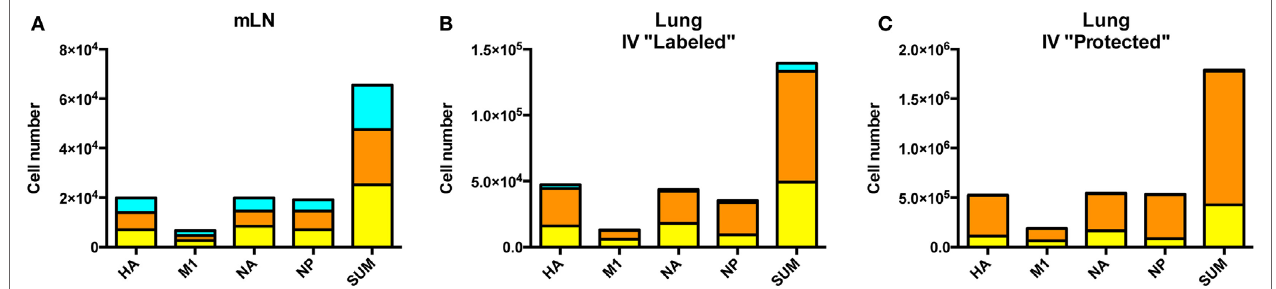
FigUre 7 | Cytokine pattern of virus-specific CD4 T cells is distinct in lymph node and lung. Cytokine profile of antigen-reactive CD4 T cells in the draining lymph node (dLN) (a) , lung vasculature, (b) and lung tissue (c) identified by protein specificity. Cells producing IL-2 only are represented in turquoise, IFN- γ alone indicated in orange and cells producing both IL-2 and IFN- γ are indicated in yellow. Data reflects responses from samples pooled from five animals. Note the differences in scales for CD4 T cells from each